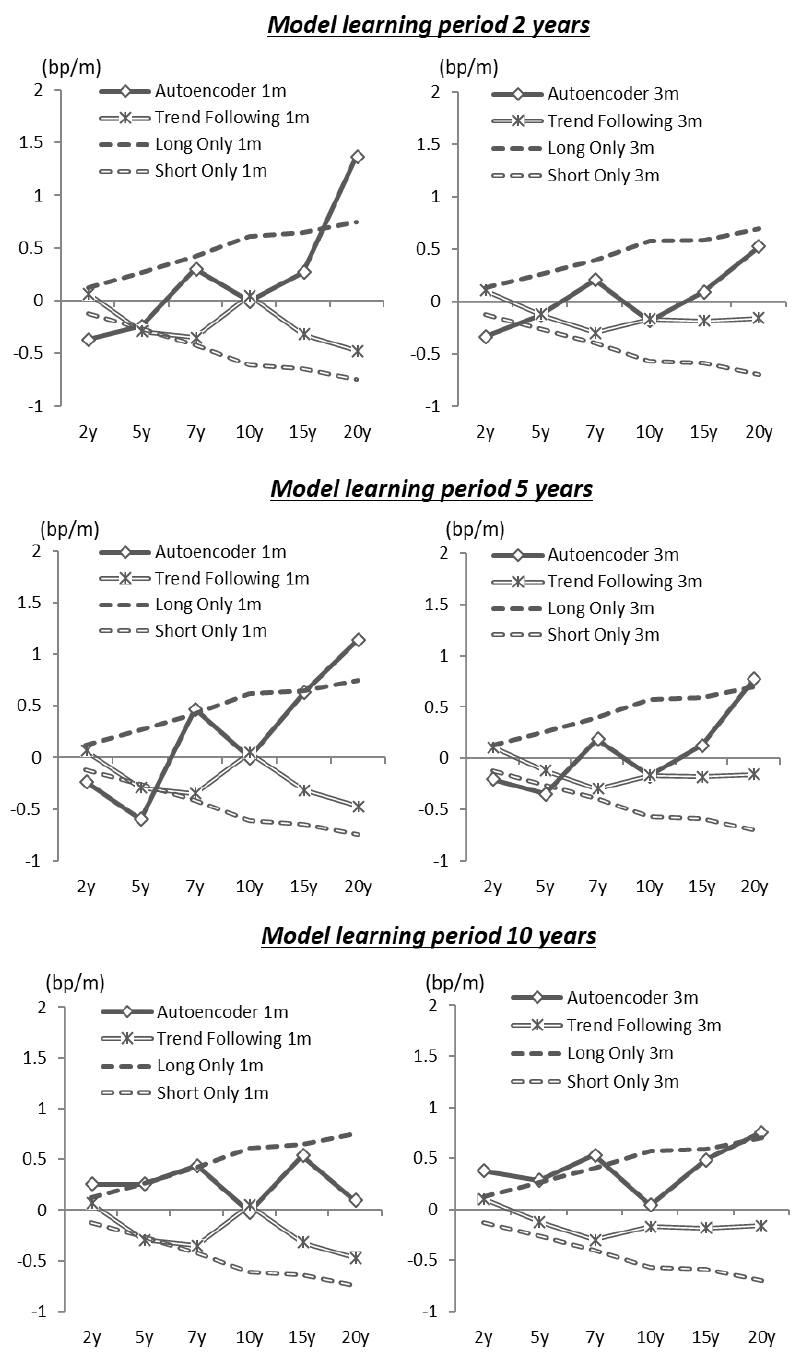
Figure A1. Average monthly capital gains with a two-node hidden layer for investment periods of 1 or 3 months.